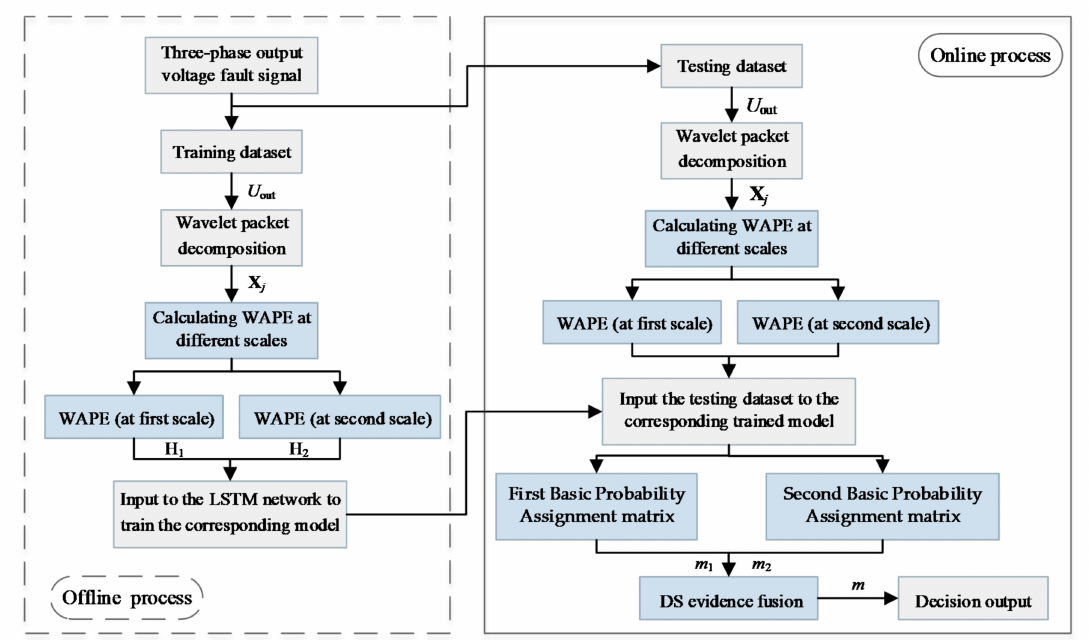
Figure 7. Flow chart of the proposed diagnostic method.